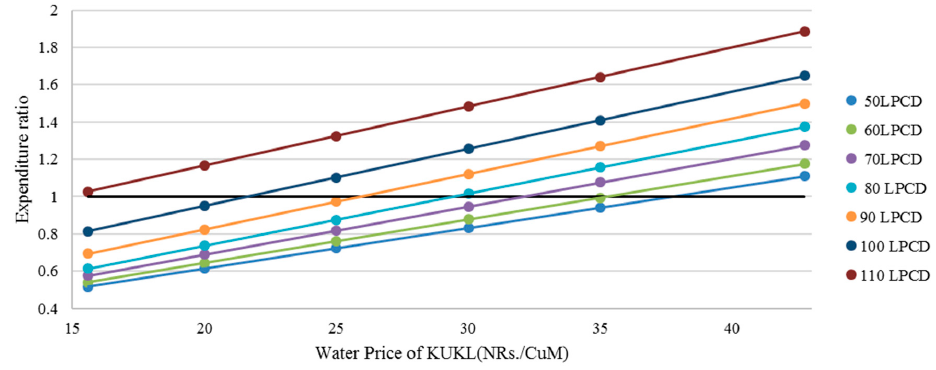
Figure 4. Comparison of average expenditure ratio with water price at various minimum water use scenarios.